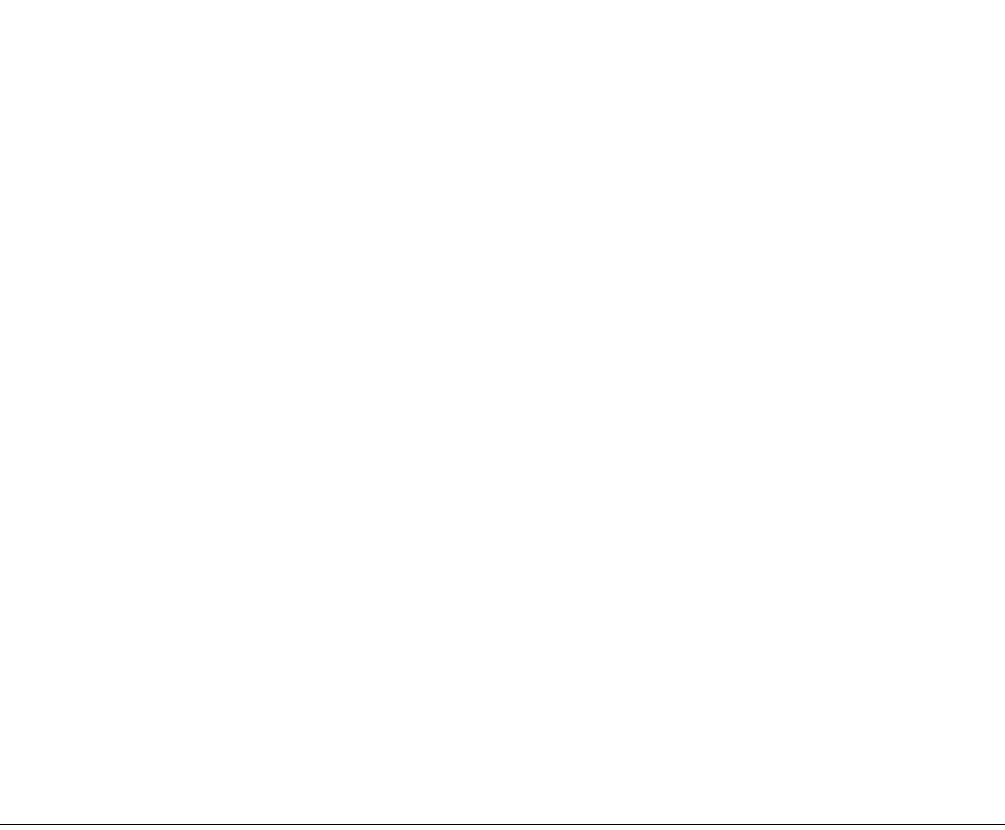
FIGUREA2 | Spatial distribution of oxy-hemoglobin waveform 2. Colors within channels indicate normalized weights for this waveform according to the color bar. (A) LRC Group. Compared to the neutral condition, there is an increase in right lateral distribution of Cluster 2 during the smiling condition,